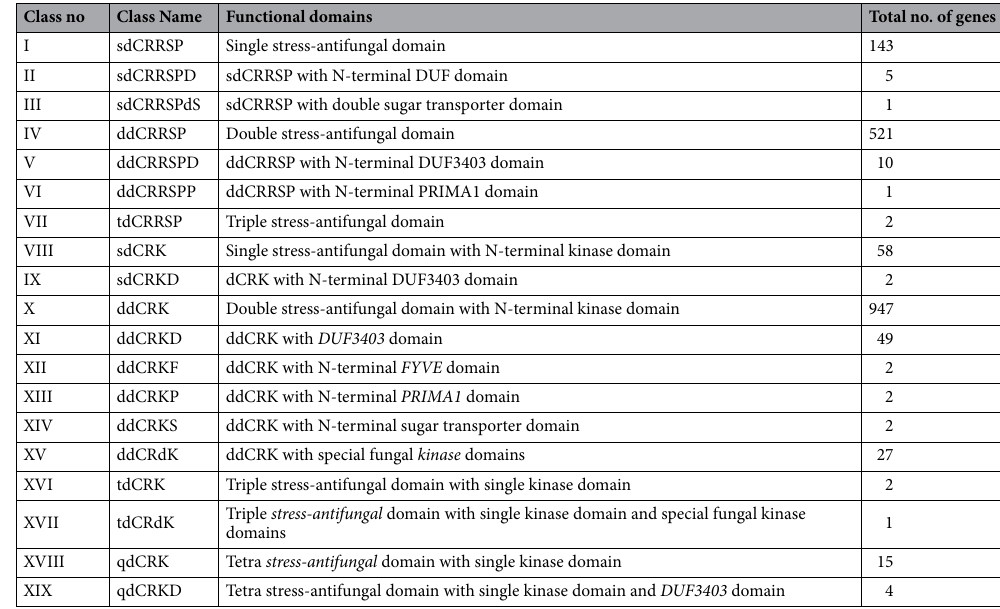
Table 2. Classes of CRKs, based on the number of stress-antifungal (DUF 26) domains, found in 35 land